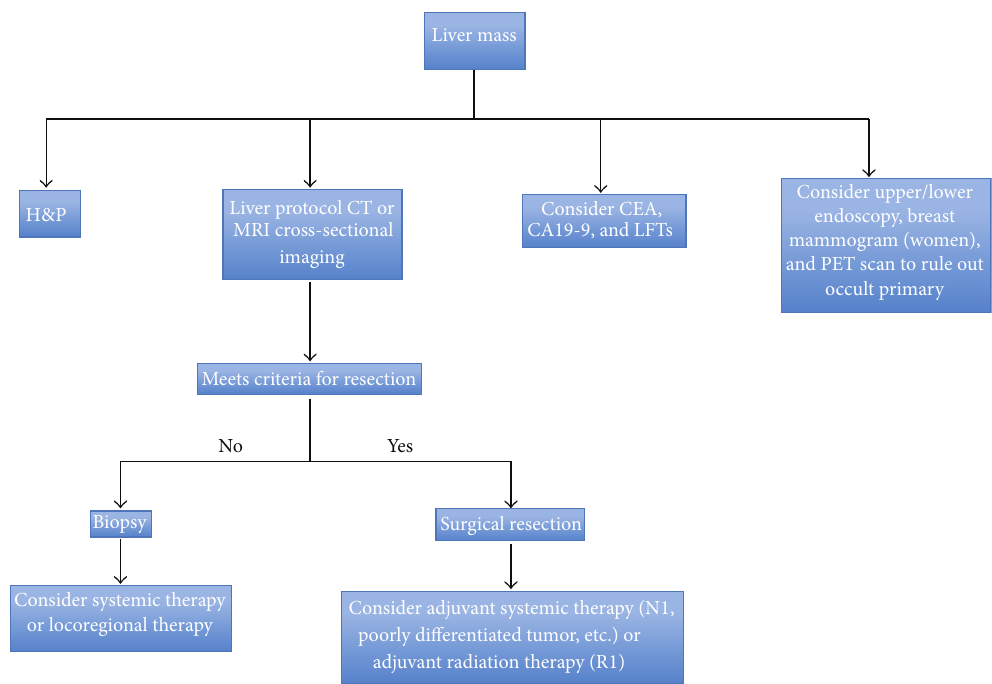
Figure 1: Treatment algorithm for intrahepatic